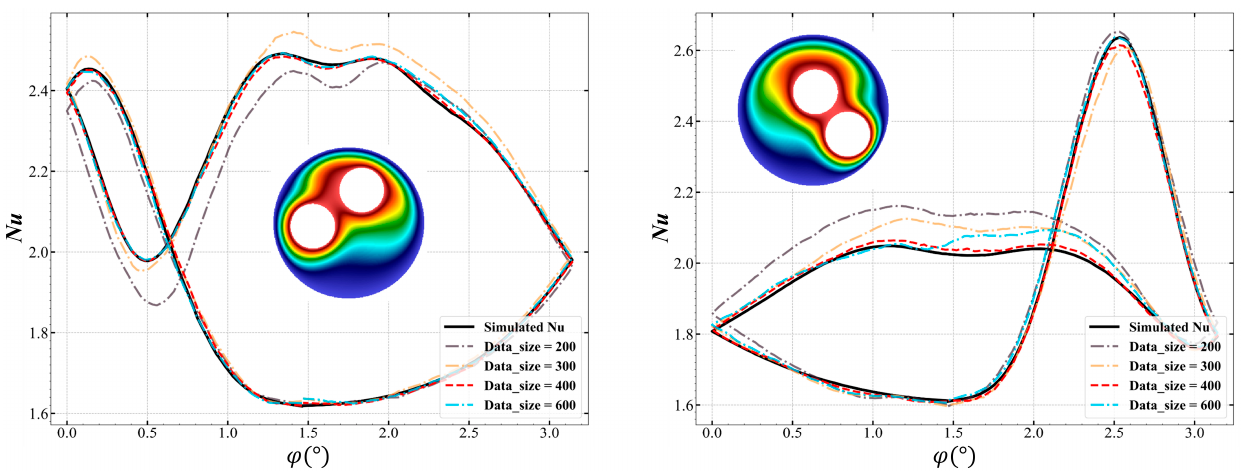
Figure 10. Nusselt number prediction of two representative double-inner-cylinder annulus with various data